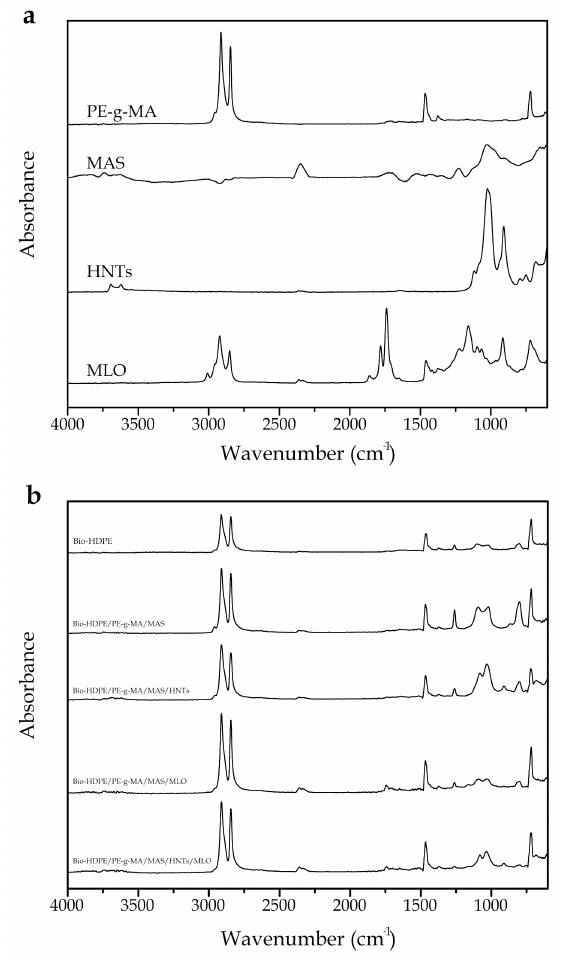
Figure 11. ( a ) Fourier transform infrared (FTIR) spectra, from bottom to top, of maleinized linseed oil (MLO), halloysite nanotubes (HNTs), micronized argan shell (MAS), Polyethylene-graft-maleic anhydride (PE-g-MA) ( b ) FTIR spectra of the different blends, from top to bottom Bio-HDPE, Bio-HDPE(67 wt.%)/PE- g-MA(3 wt.%)/MAS(30 wt.%),Bio-HDPE(67 wt.%)/PE-g-MA(3 wt.%)/MAS(30 wt.%)/HNTs(7.5 phr), Bio-HDPE(67 wt.%)/PE-g-MA(3 wt.%)/MAS(30 wt.%)/MLO(7.5 phr), Bio-HDPE(67 wt.%)/PE-g-MA (3 wt.%)/MAS(30 wt.%)/HNTs(3.75 phr)/MLO(3.75